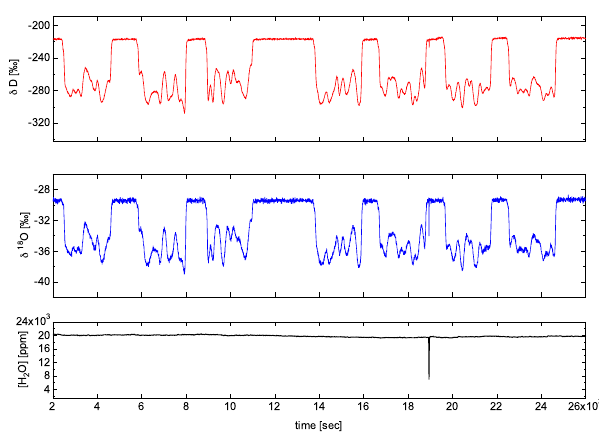
Fig. 2. Raw signals spanning 7 CFA runs on 29 May 2010.